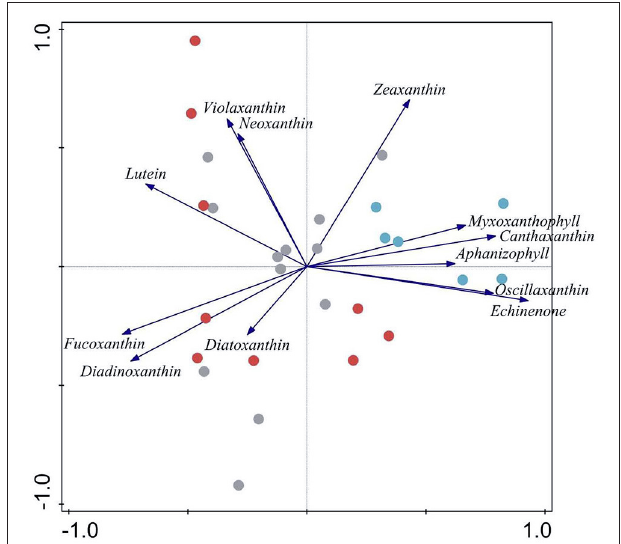
FIGURE 7 | Principal component analysis of the epiphytic algal groups pigment composition in %. Gray lakes are for fishless lakes, red as for lakes invaded with trout and blue as for lakes invaded with dense minnow populations. Percentage of the variance in marker pigment composition explained by the first two axes variance is